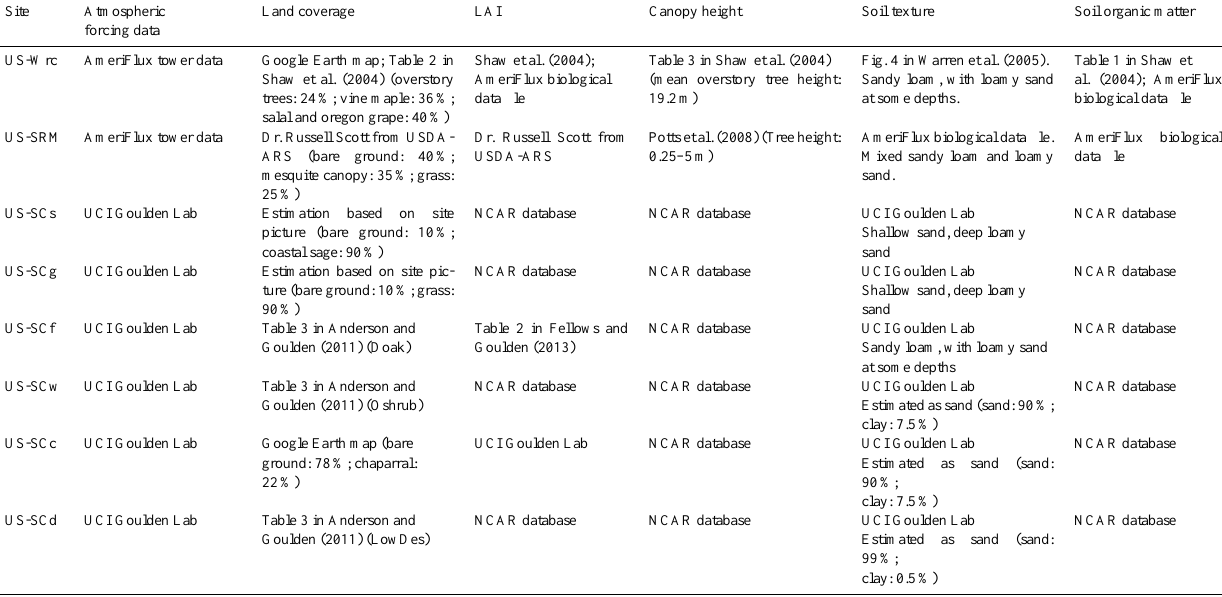
Table 2. Sources of data for model inputs.